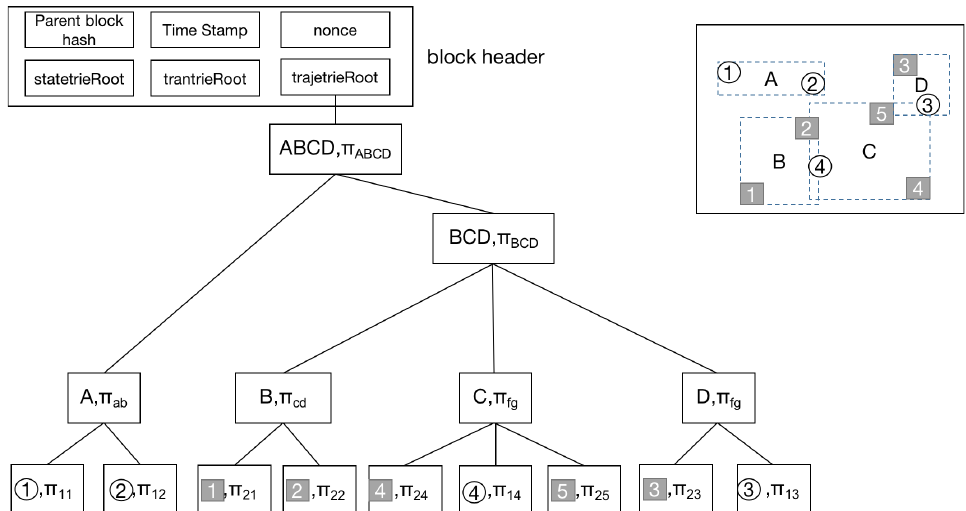
Figure 6. Trajectories stored in Verkle